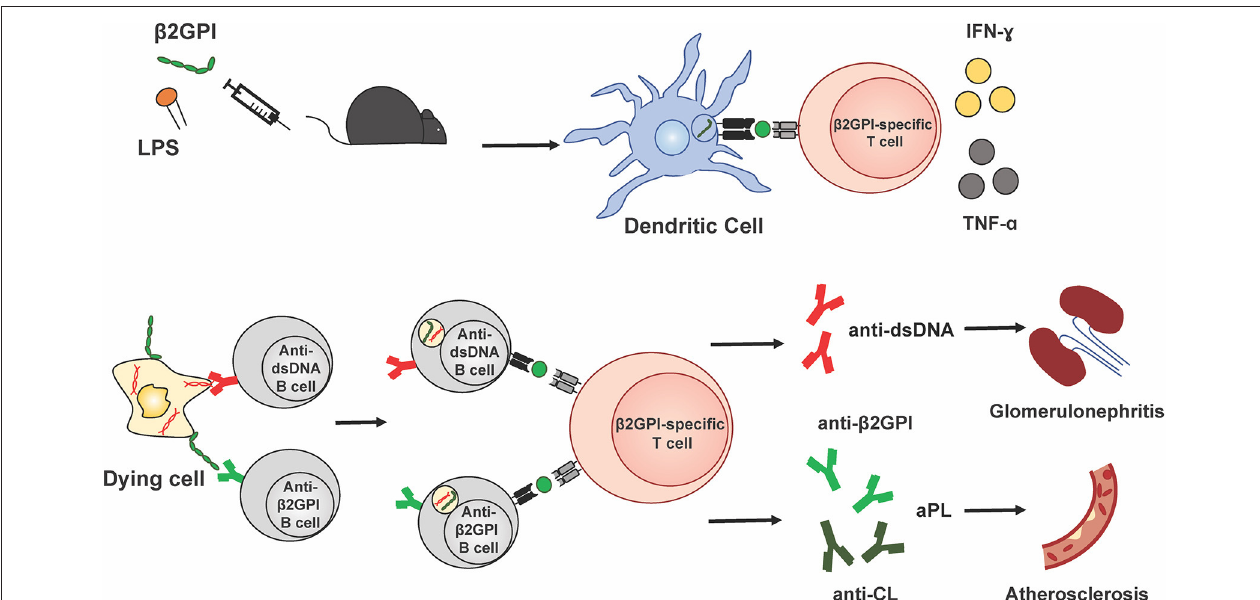
FIGURE 1 | β 2GPI-reactive T cells promote autoantibody production and pathology in APS and SLE. This simplified schematic diagram illustrates a possible mechanism by which β 2GPI-reactive T cells may promote the development of multiple serological and clinical outcomes. Immunization of mice with β 2GPI and lipopolysaccharide (LPS) results in the presentation of β 2GPI-derived peptides (green circles) to T cells by dendritic cells and activation and proliferation of β 2GPI-reactive CD4T cells. In the second phase of the response, β 2GPI-reactive CD4T cells could provide help not only to B cells specific for β 2GPI, but also to